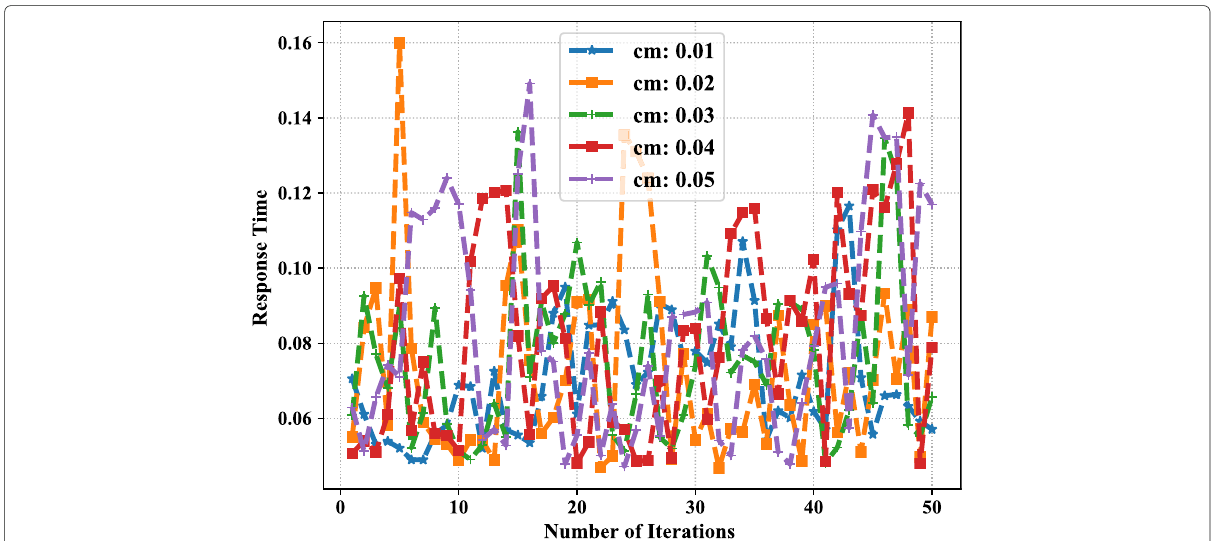
Fig. 7 Response times with different values of mutation